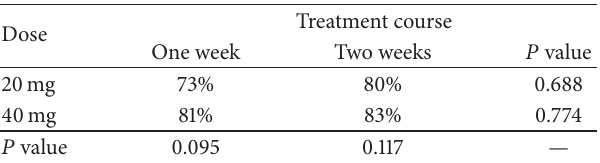
Table 6: Comparison of coincident rates of rabeprazole tests of different doses and treatment courses.